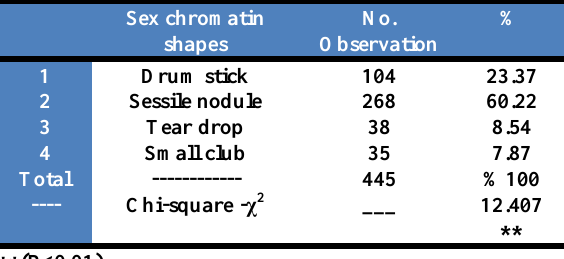
Table, 1. Distribution of sample study according to Sex chromatin shapes